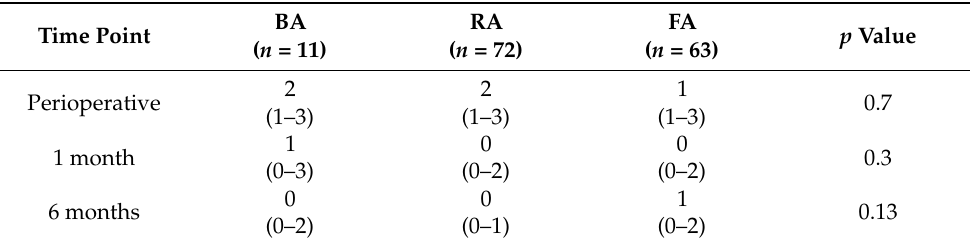
Table 4. EQ-5D-3L Questionnaire overall results.